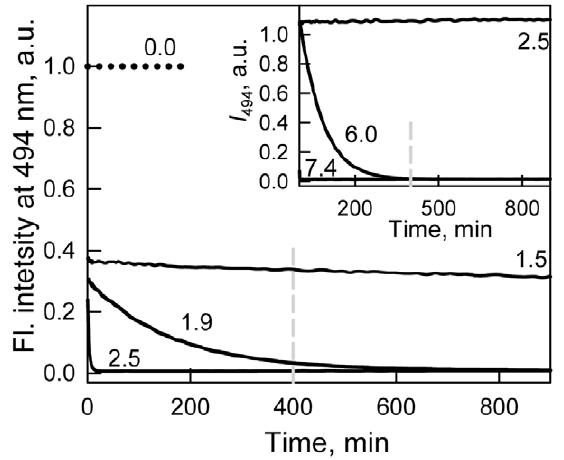
Figure 3. The rate of sfGFP unfolding induced by different denaturing agents. The influence of GTC ( main panel ) or GdnHCl ( inset ) was recorded by chromophore fluorescence intensity at 494 nm. l ex ~ 365 nm . Numbers on the curves are final denaturant concentra- tions in protein samples. The dashed vertical indicates the time at which the values of chromophore fluorescence intensity were compared. doi:10.1371/journal.pone.0048809.g003 PLOS ONE |